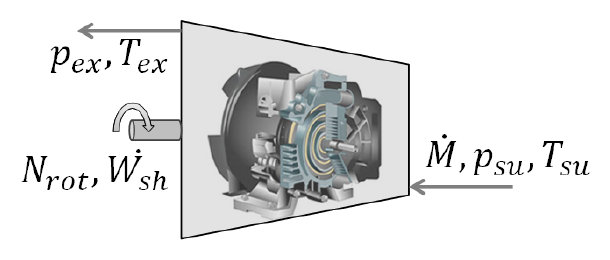
Figure 8. View of the tested scroll expander with the measured variables.